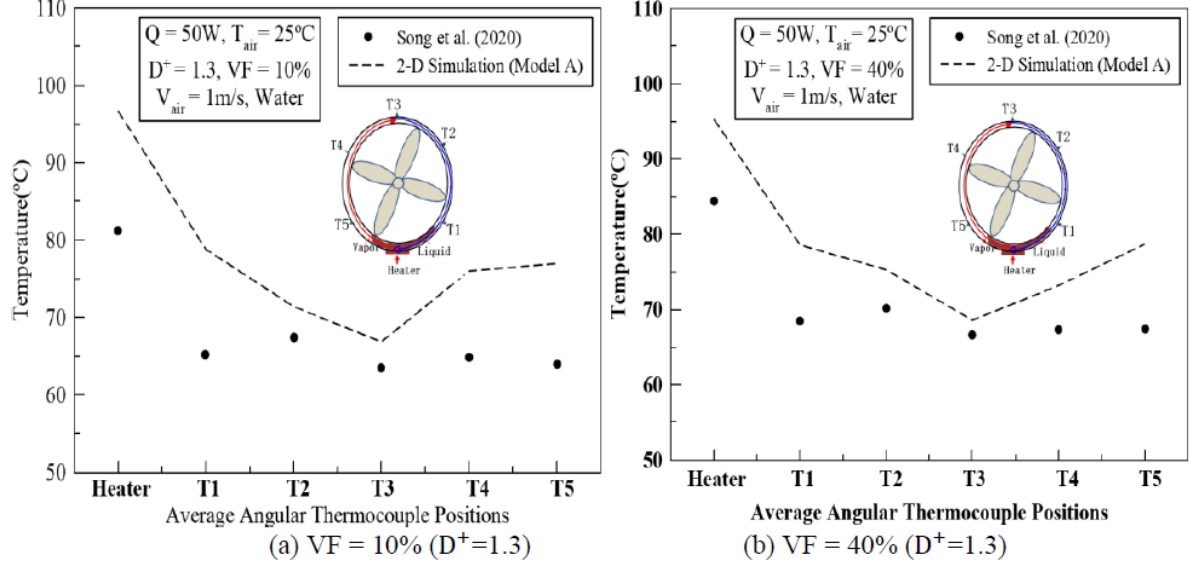
Figure 10. Comparison between experiment and 2D simulation.